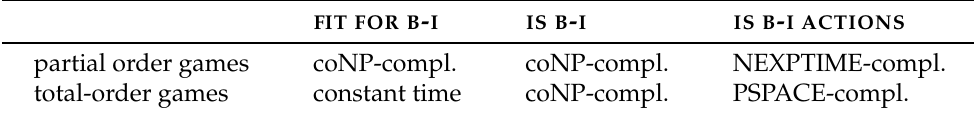
Table 2. Overview of complexity results surrounding backwards induction in partial order